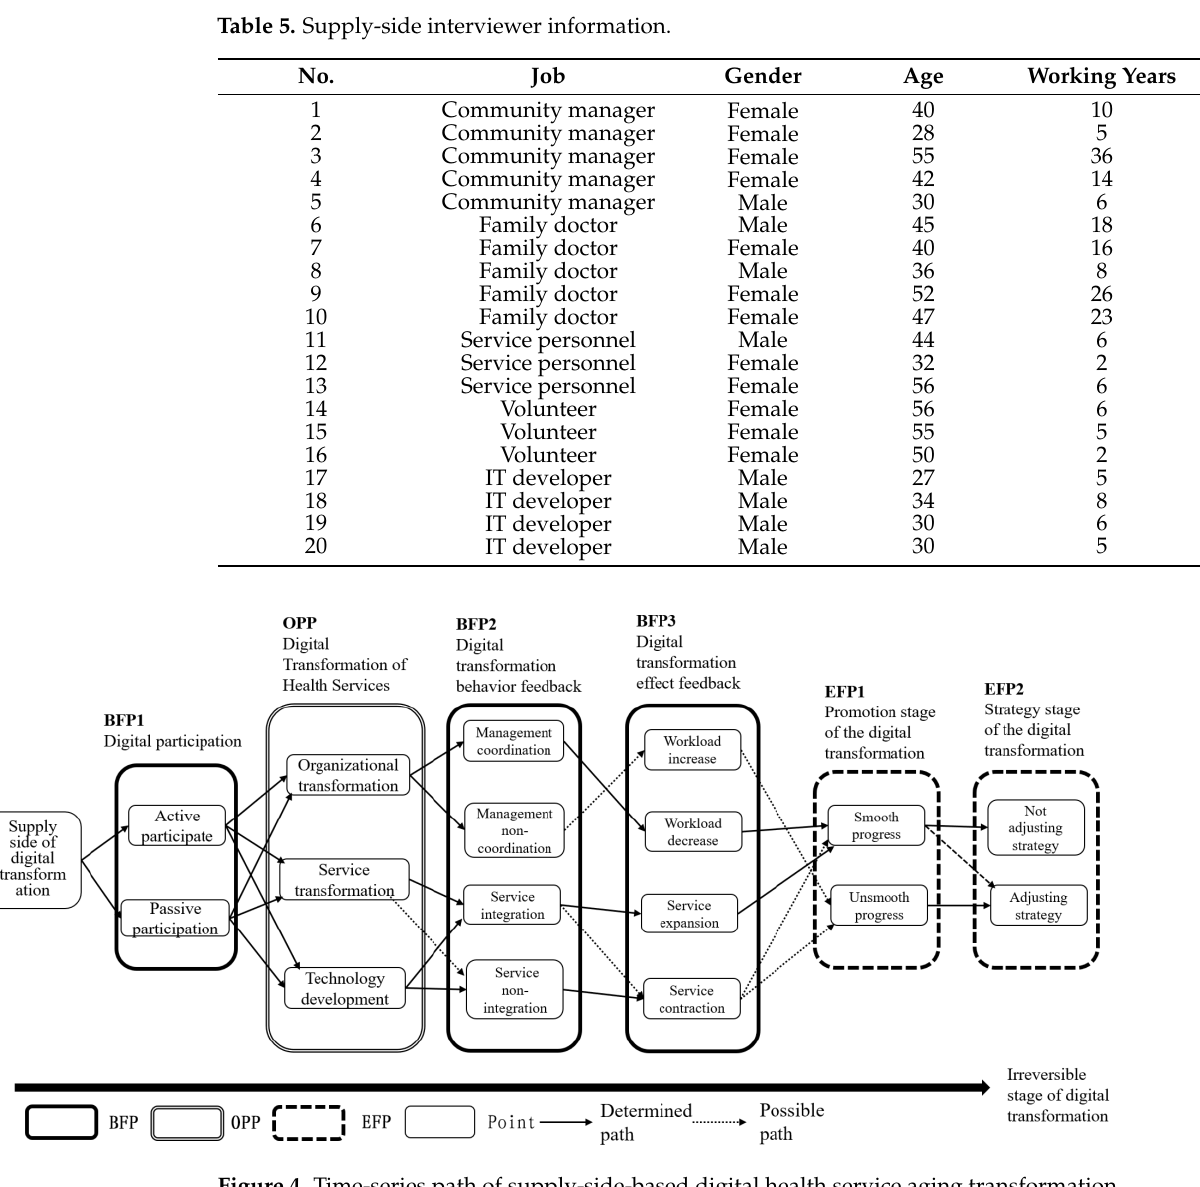
Table 6. Demand-side interviewer information.